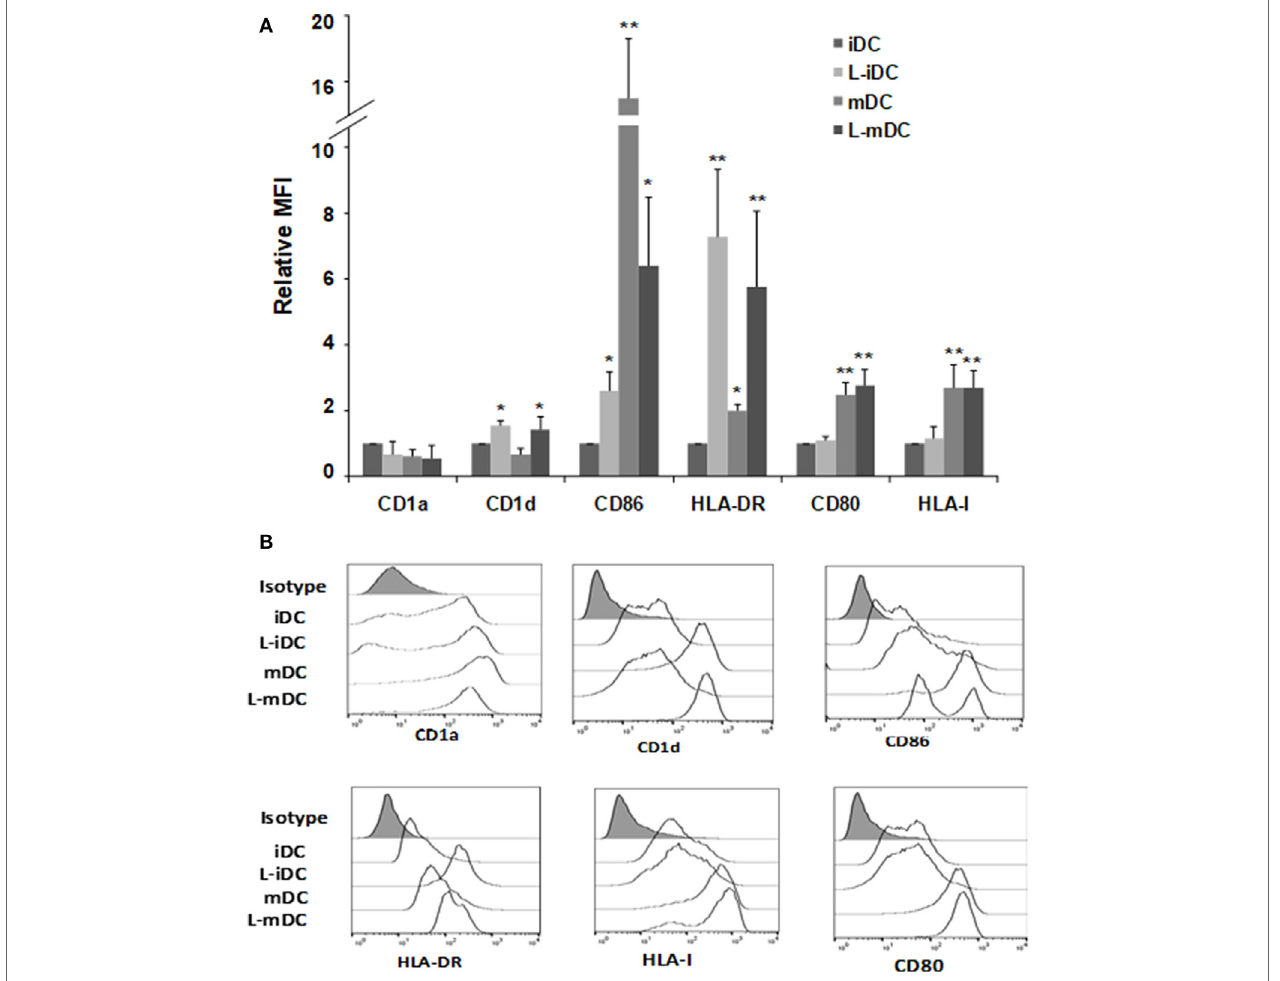
FigUre 1 | Monocyte-derived dendritic cells (DCs) differentiated in the presence of lenalidomide (L-DCs) increase their surface expression of CD1d, CD86, and HLA-DR molecules. Expression of different cell surface markers in monocyte-derived DCs was measured by flow cytometry. (a) Data shown are the relative mean fluorescence intensity (MFI) ± SDs from 12 independent experiments, comparing L-iDCs, matured DCs (mDCs), or L-mDCs to iDCs. (B) Histograms from a representative experiment are shown (* p < 0.05, ** p <